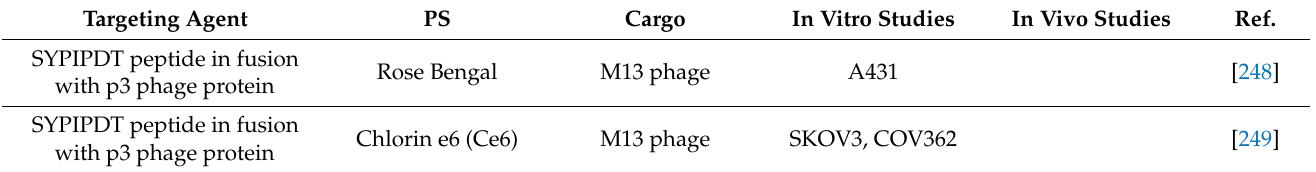
Table 16. EGFR-targeted PDT performed with phages expressing anti-EGFR peptides. Targeting Agent PS Cargo In Vitro Studies In Vivo Studies